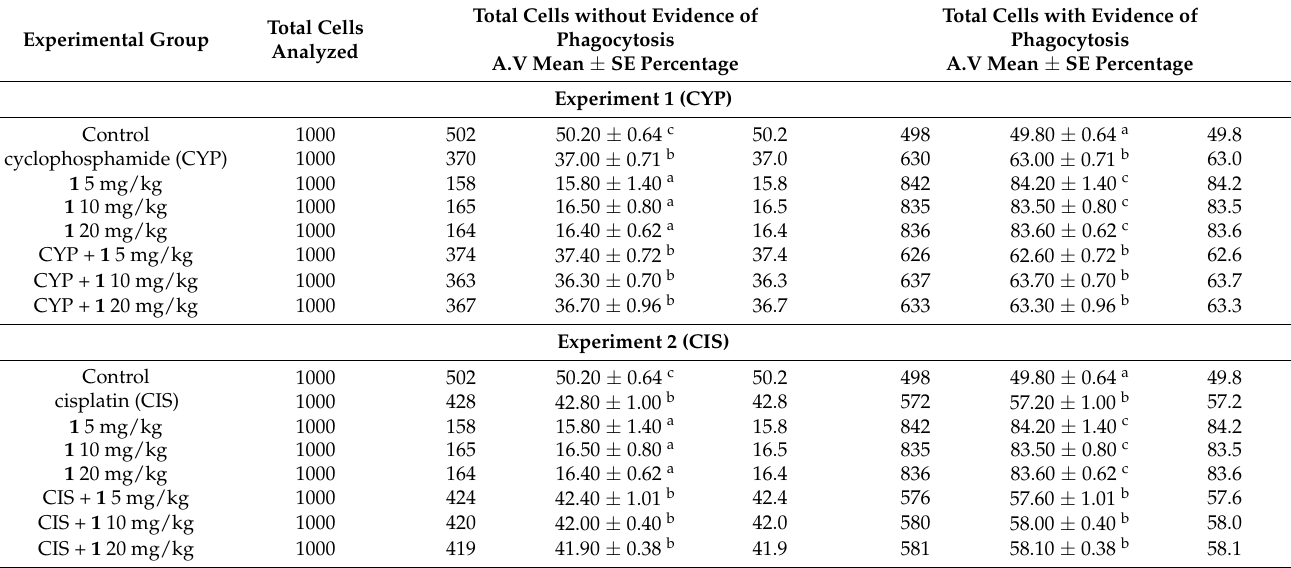
Table 4. Absolute value, mean ± Standard error, and percentage referring to the splenic phagocytosis assay in Swiss mice.